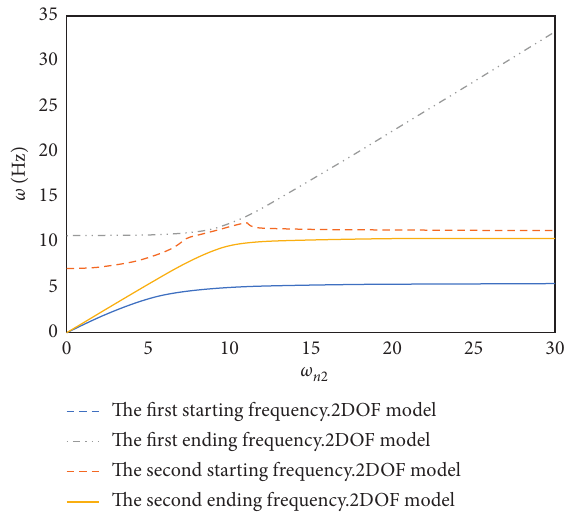
Figure 20: The effect of ω